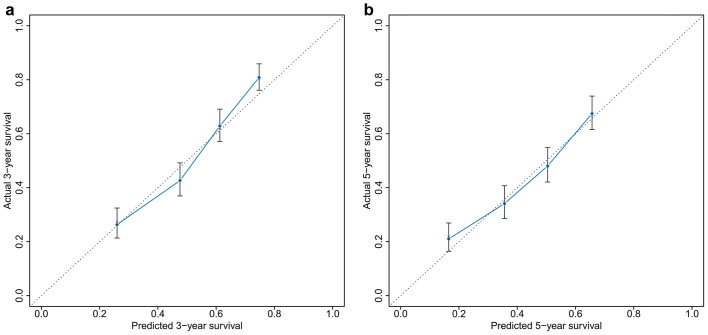
A calibration curve for predicting patient survival at (A) 3 and (B) 5 years.The calibration curve shows how the predictions from the nomogram compared to the actual outcomes for the 1,031 patients.